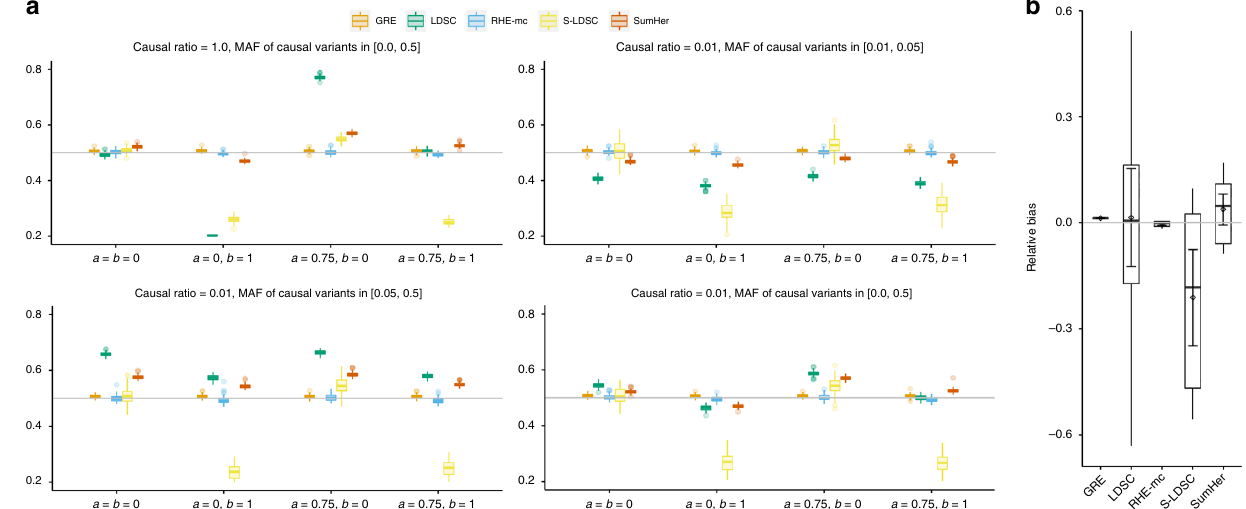
Fig. 1 Comparison of estimates of genome-wide SNP heritability from RHE-mc with LDSC, GRE, S-LDSC, and SumHer in large-scale simulations ( N = 337,205 unrelated individuals, M = 593,300 array SNPs). a We compared methods for heritability estimation under 16 different genetic architectures. We set true heritability to 0.5 and varied the MAF range of causal variants (MAF of CV), the coupling of MAF with effect size ( a = 0 indicates no coupling with MAF and a = 0.75 indicates coupling with MAF), and the effect of local LD on effect size ( b = 0 indicates no dependence on LDAK weights and b = 1 indicates dependence on LDAK weights) (see “ Methods ” section). Each boxplot represents estimates from 100 simulations. b Relative bias of each method (as a percentage of the true h 2 ) across 16 distinct MAF-dependent and LD-dependent architectures. Each boxplot contains 16 points; each point is the relative bias estimated from 100 simulations under a single genetic architecture. Points and error bars represent the mean and ±2 SE. In a and b , boxplot whiskers extend to the minimum and maximum estimates located within 1.5× interquartile range (IQR) from the fi rst and third quartiles, respectively. Here, we run RHE-mc using 24 bins formed by the combination of six bins based on MAF as well as four bins based on quartiles of the LDAK score of a SNP (see “ Methods “ section). We run S-LDSC with only 10 MAF bins (see Supplementary Table 5). To do a fair comparison, for every method, we computed LD scores and LDAK weights by using in-sample LD, and in all simulations we aim to estimate the SNP-heritability explained by the same set of M SNPs.